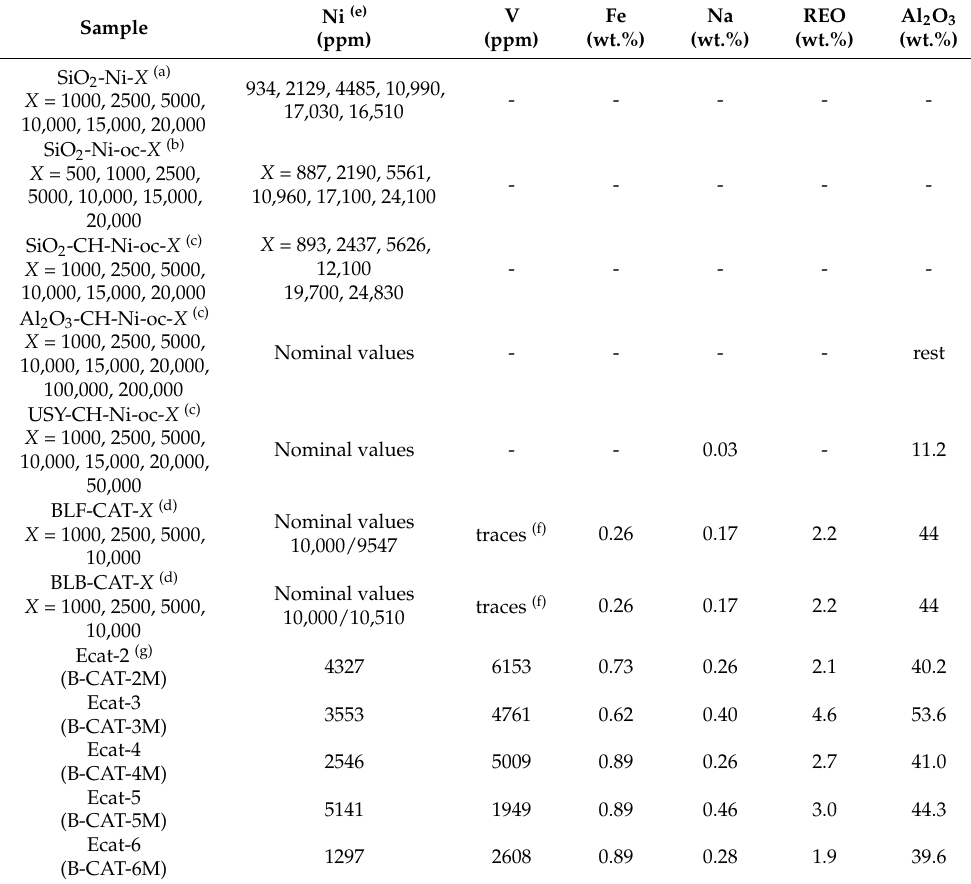
Table 1. Chemical composition of spent equilibrium FCC catalysts and lab-prepared Ni-loaded